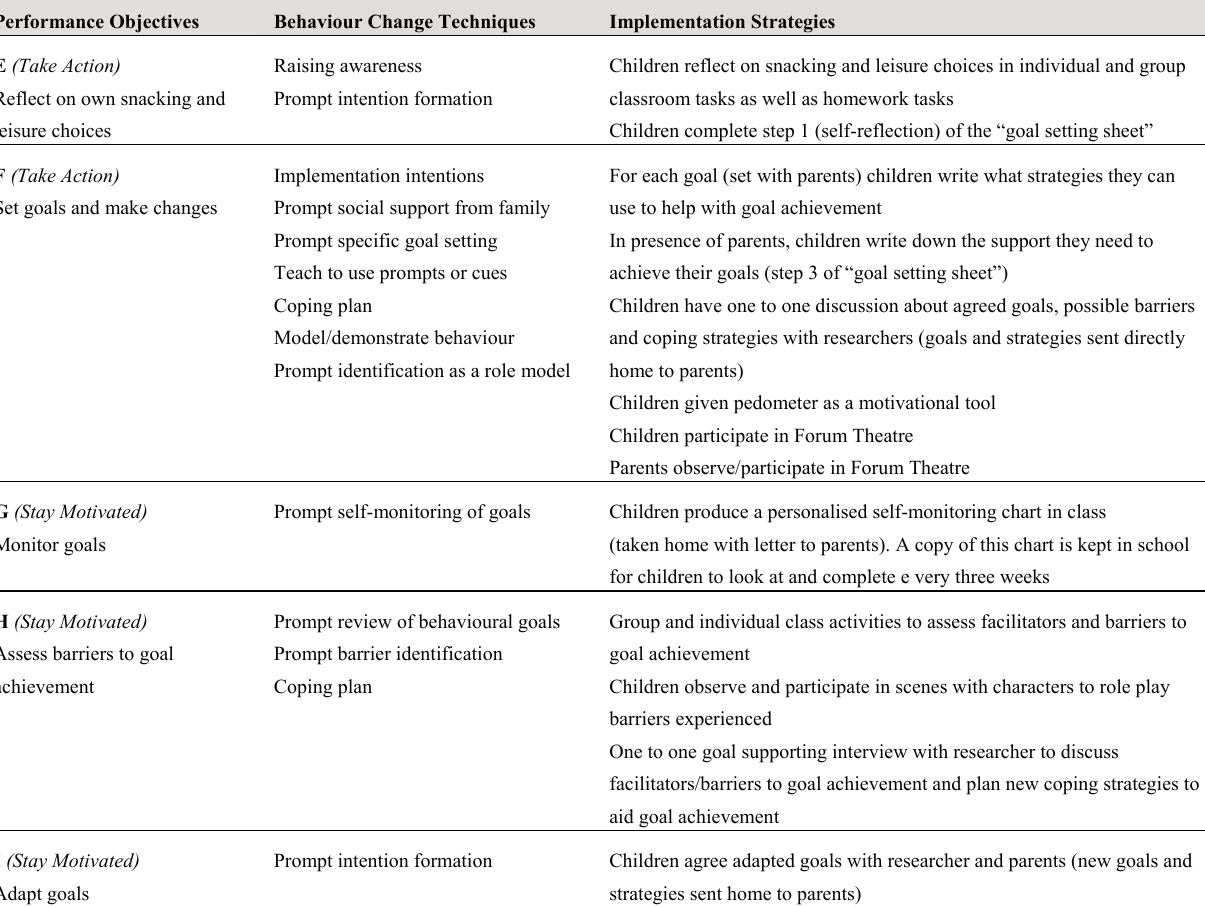
Table 3. “Take Action” and “Stay Motivated” associated behaviour change techniques and strategies for performance